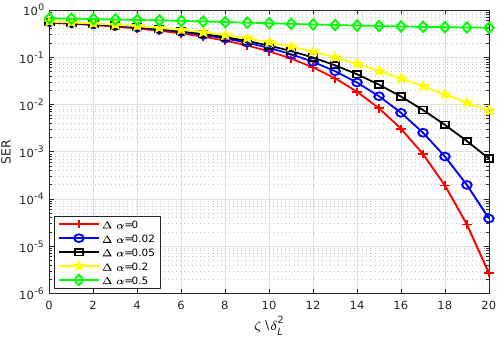
Figure 9. The anti-performance for proposed scheme on parameter α , where ( m , c ) = ([ 0,0,0,0 ] , [ 0,0,0,0 ]) .